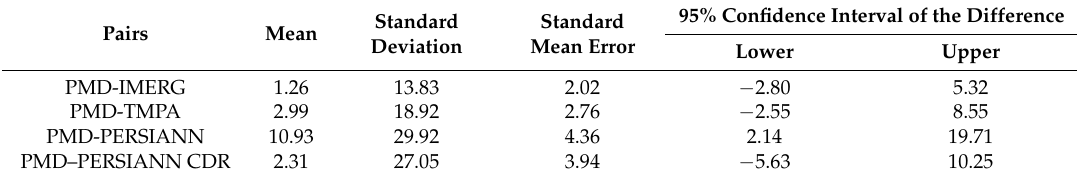
Table 4. Paired sample t -test of satellite products over the five climate zones.